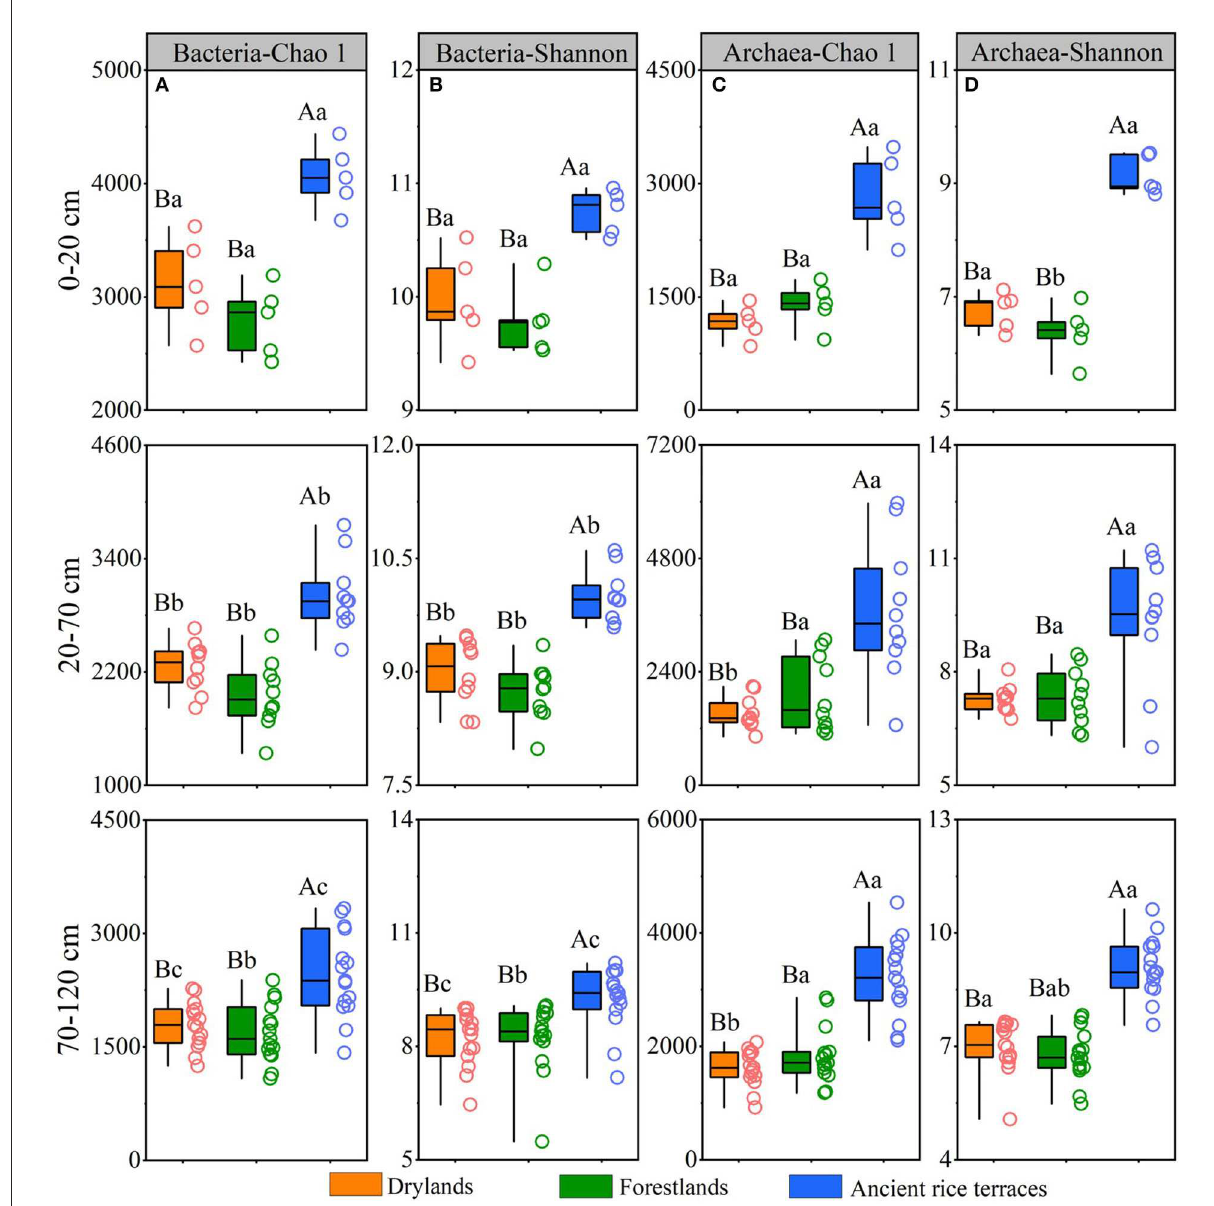
FIGURE3 Soil prokaryotic richness and diversity of three land use types in different soil horizons. Various capital letters stand for significant differences among diverse land use types, and diverse lower-case letters indicate significant differences among diverse soil horizons.